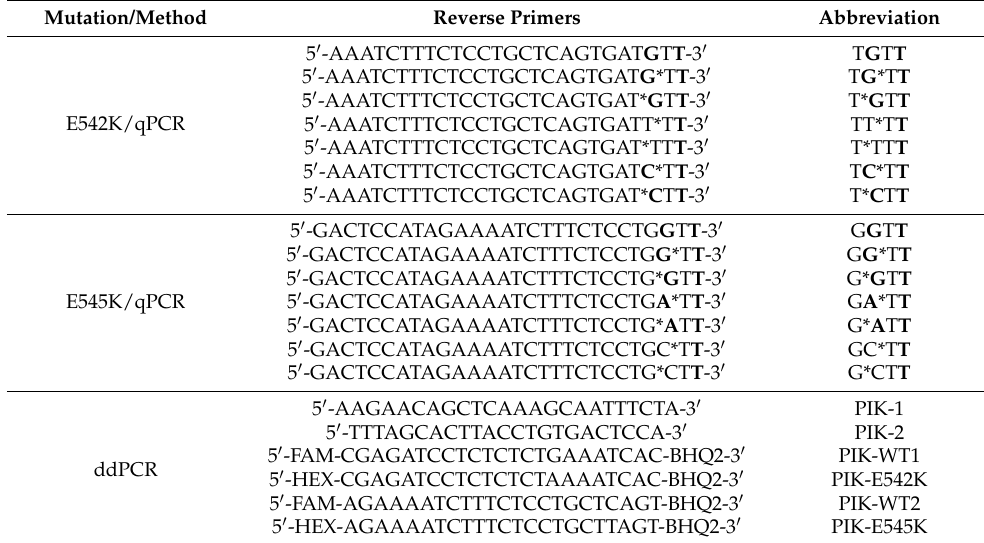
Table 2. AS primers for the E542K and E545K mutation